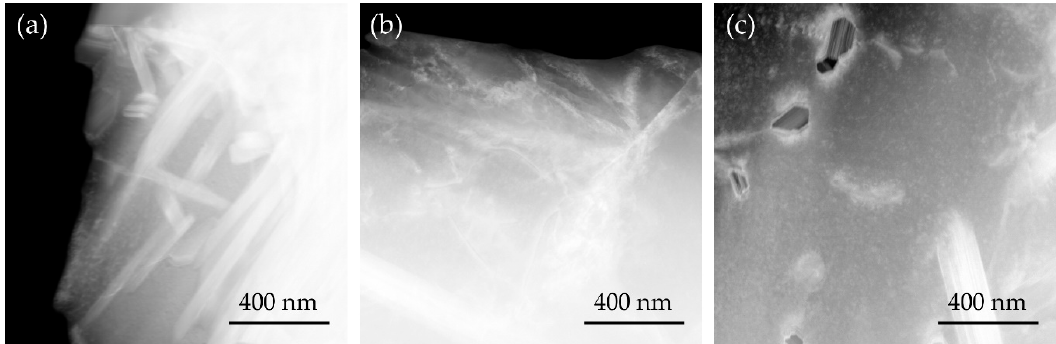
Figure 5. (S)TEM images 80,000x: ( a ) Ti + 30 vol. % B 4 C, ( b ) Ti + 30 vol. % B 4 C + 20 vol. % Ti-Al(1) and ( c ) Ti + 30 vol. % B 4 C + 20 vol. % Ti-Al(2). Metals 2019 , 9 , x FOR PEER REVIEW